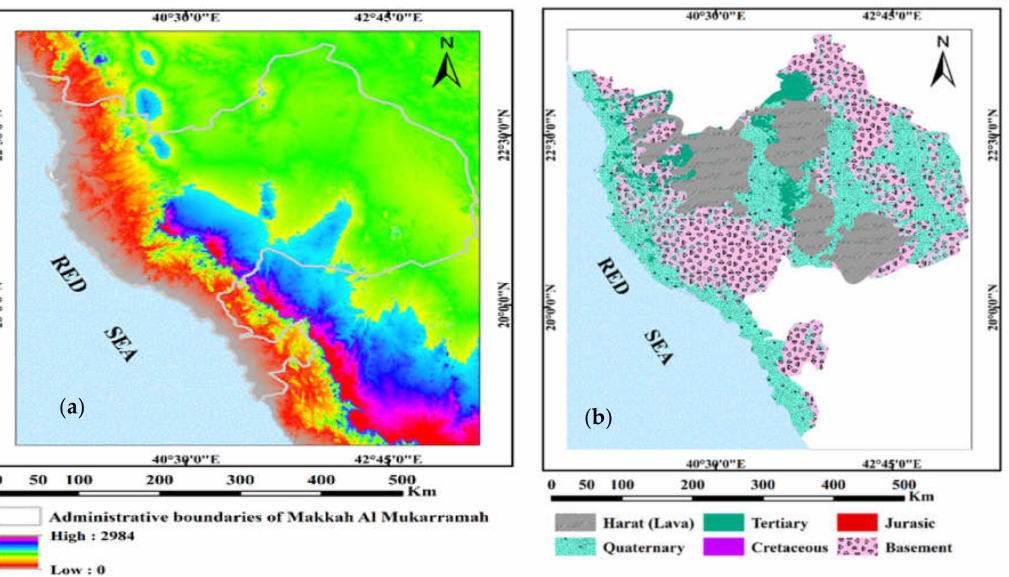
Figure 2. ( a ) Digital elevation model (DEM) and ( b ) geological map of Makkah Al-Mukarramah Province, Saudi Arabia.